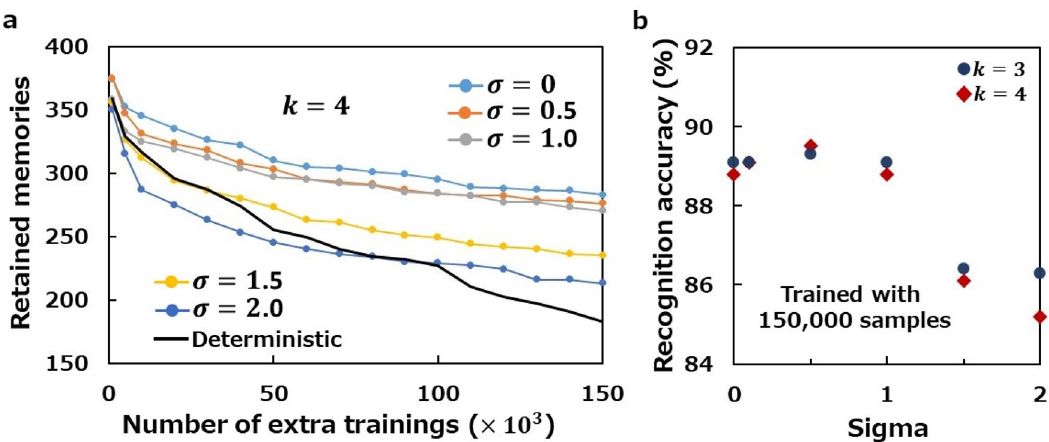
Figure 5. Effect of variability on memory maintenance and recognition accuracy. ( a) Memory maintenance characteristics obtained with sigmoidal stochastic S-STDP in the case of k = 4 (with p = 0.2 and q = 0.08 ), with σ being varied from 0 to 2.0 as well as that obtained with deterministic S-STDP as a reference (taken from Fig. 1b). (b) Recognition accuracy after training with 150,000 samples as a function of σ for k = 3 and 4